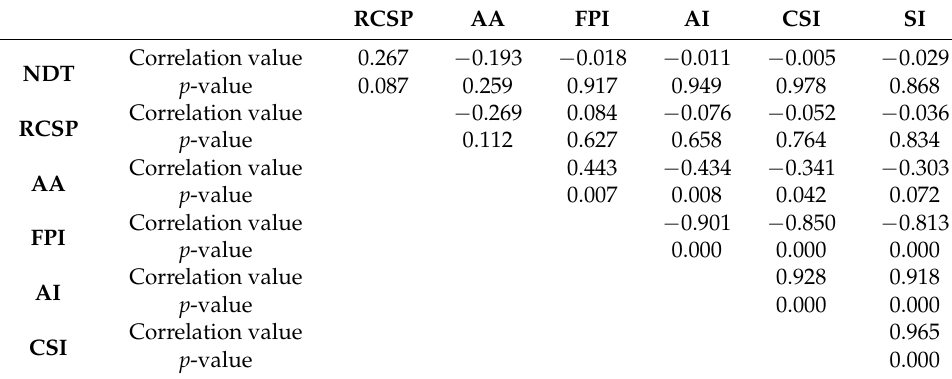
Table 3. Pearson’s correlation values of the neutral foot group between all tests.